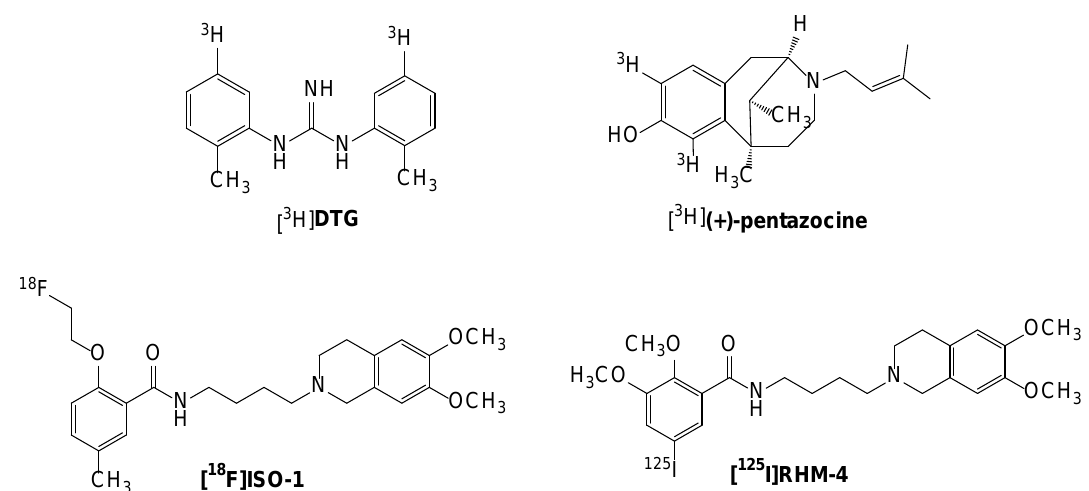
Figure 1. Structures of radioligands used in in vitro binding and PET imaging studies of the s2 receptor/TMEM97 in cancer patients.